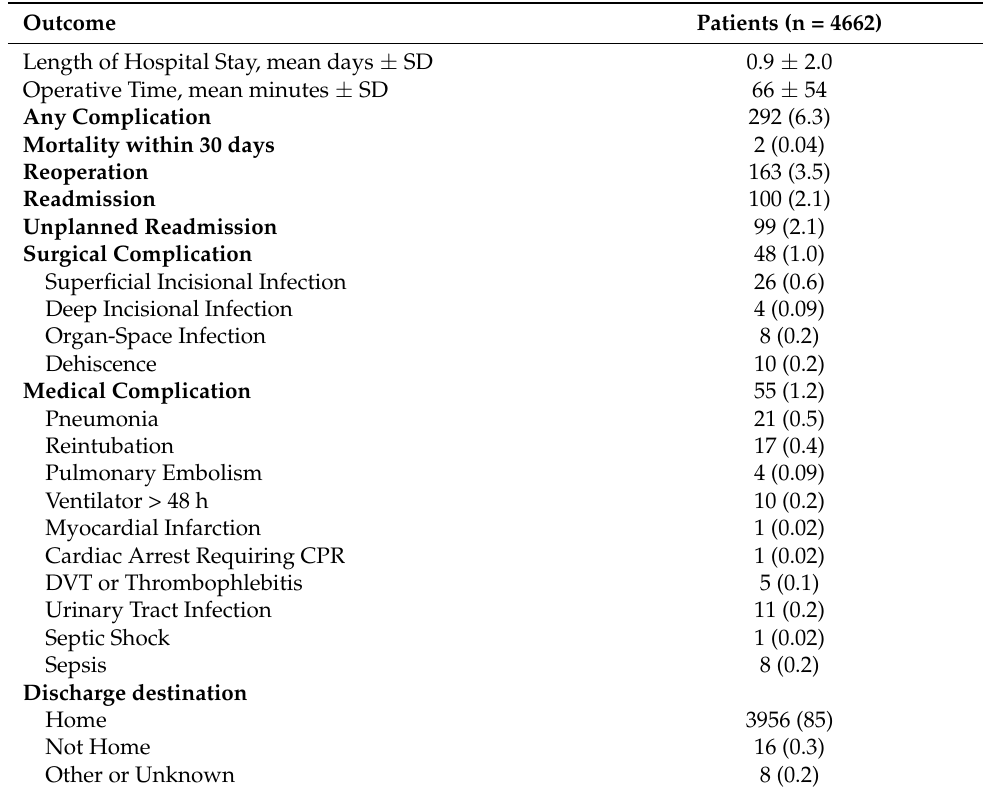
Table 4. Operative and postoperative outcomes for all patients undergoing head and neck OSA surgery. Reported as n (%), unless otherwise stated.